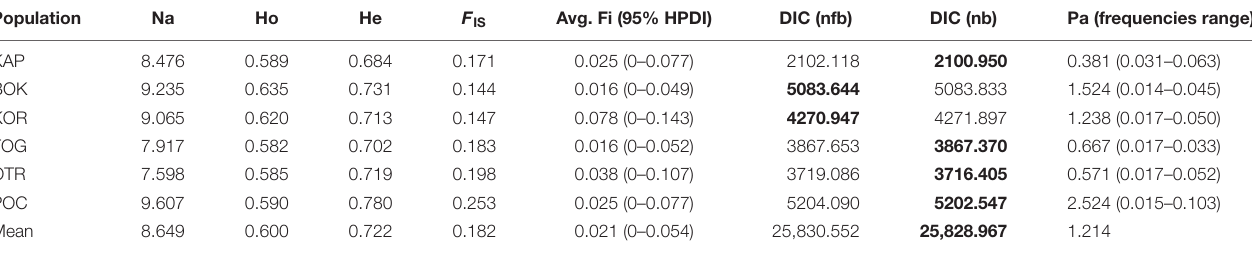
TABLE 2 | Estimators of genetic diversity in 174 samples of Gibbula divaricata at 21 microsatellite loci. Population Na Ho He F IS Avg. Fi (95% HPDI) DIC (nfb) DIC (nb) Pa (frequencies range) KAP